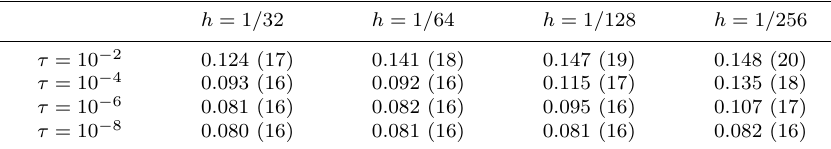
Table 3. Convergence factors and number of iterations of the multigrid method. h = 1 /